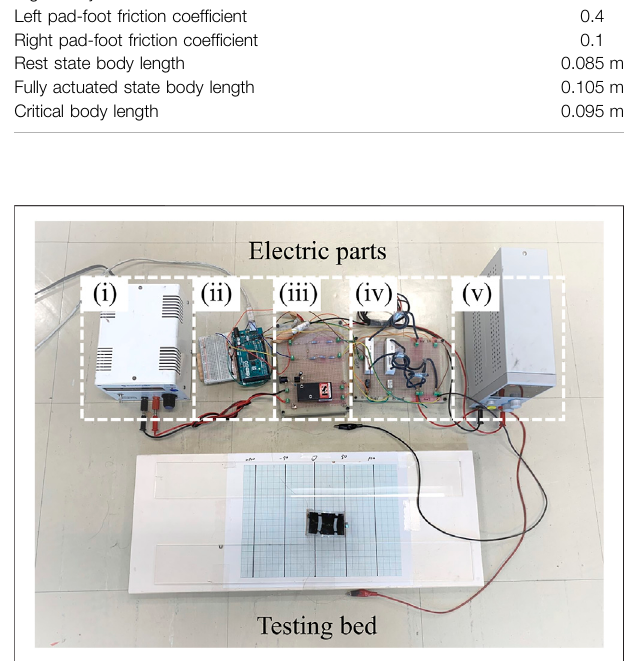
FIGURE 9 | Overview of the whole experiment setup showing the electricpartsandtherobotlocomotiontestingbed.(i)Adjustableinputvoltage fortheHVDCconverter;(ii)ArduinoMega;(iii)HVDCconverter;(iv)relayboard; and (v) relay power supply.